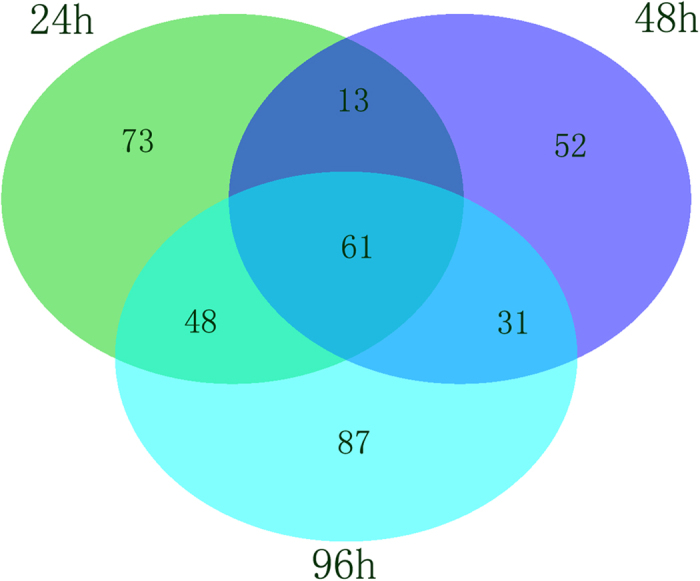
Changed proteome distribution between different time points.Venn diagram showing unique and shared proteins between time points.